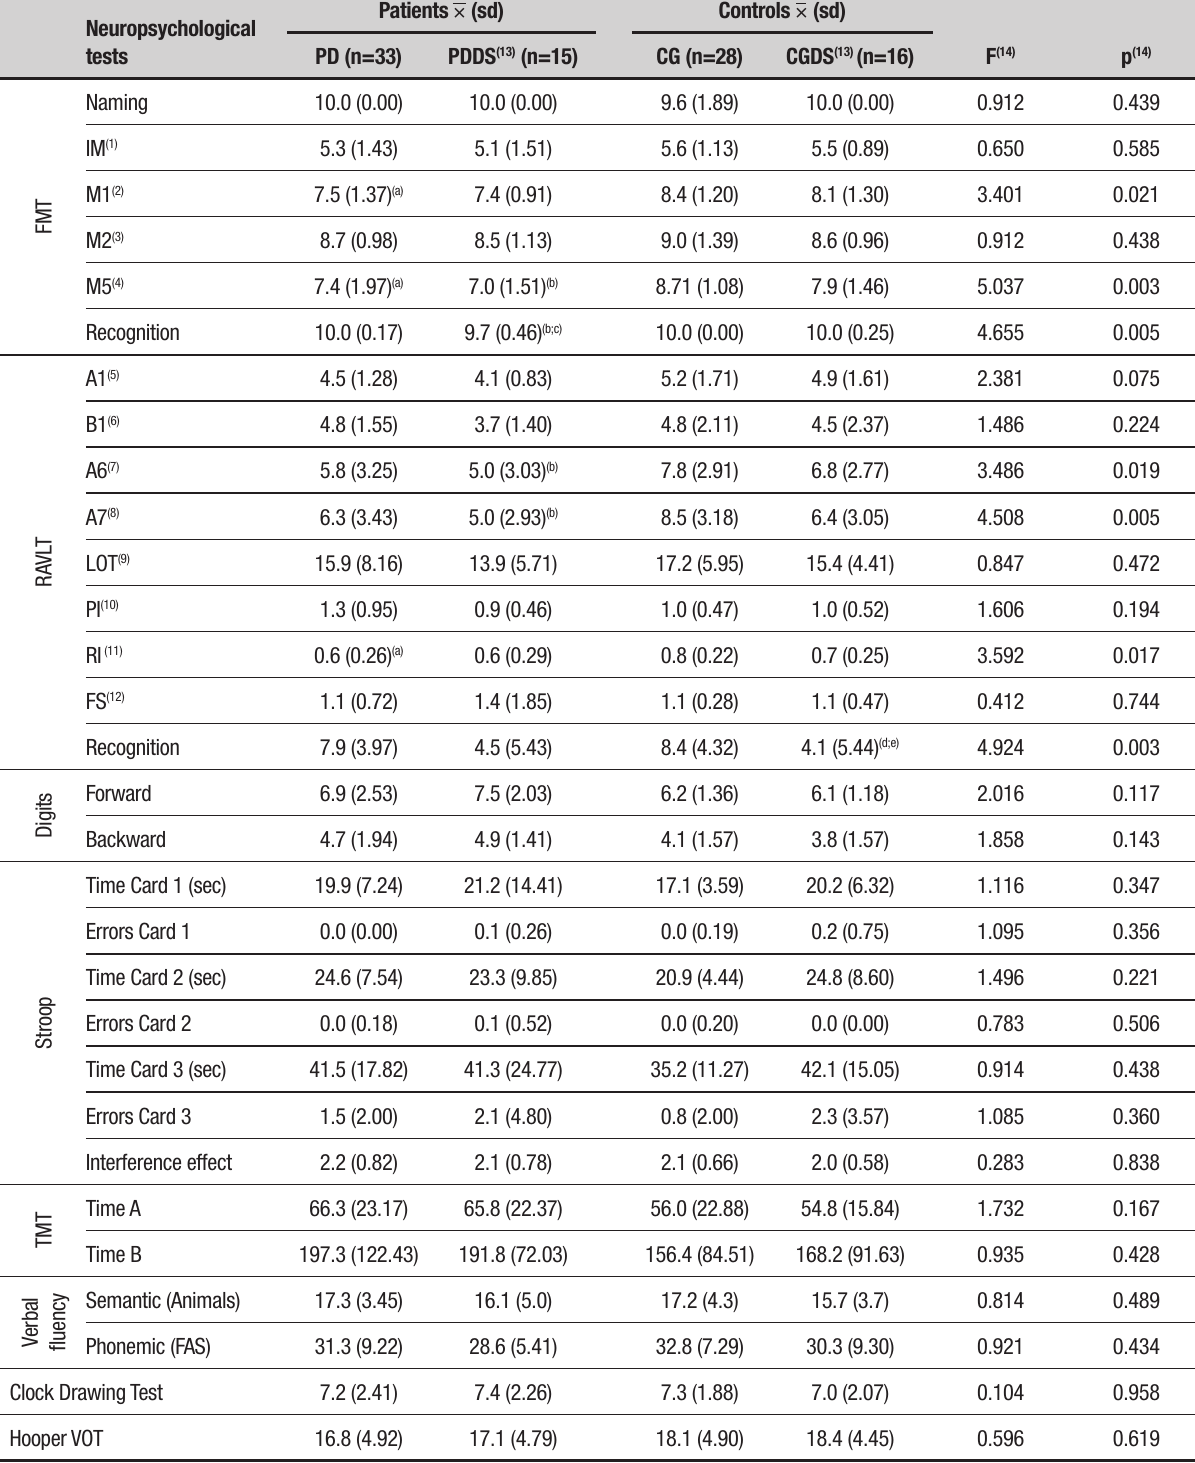
Table 2. Performance of patients and controls on the neuropsychological tests (raw scores).